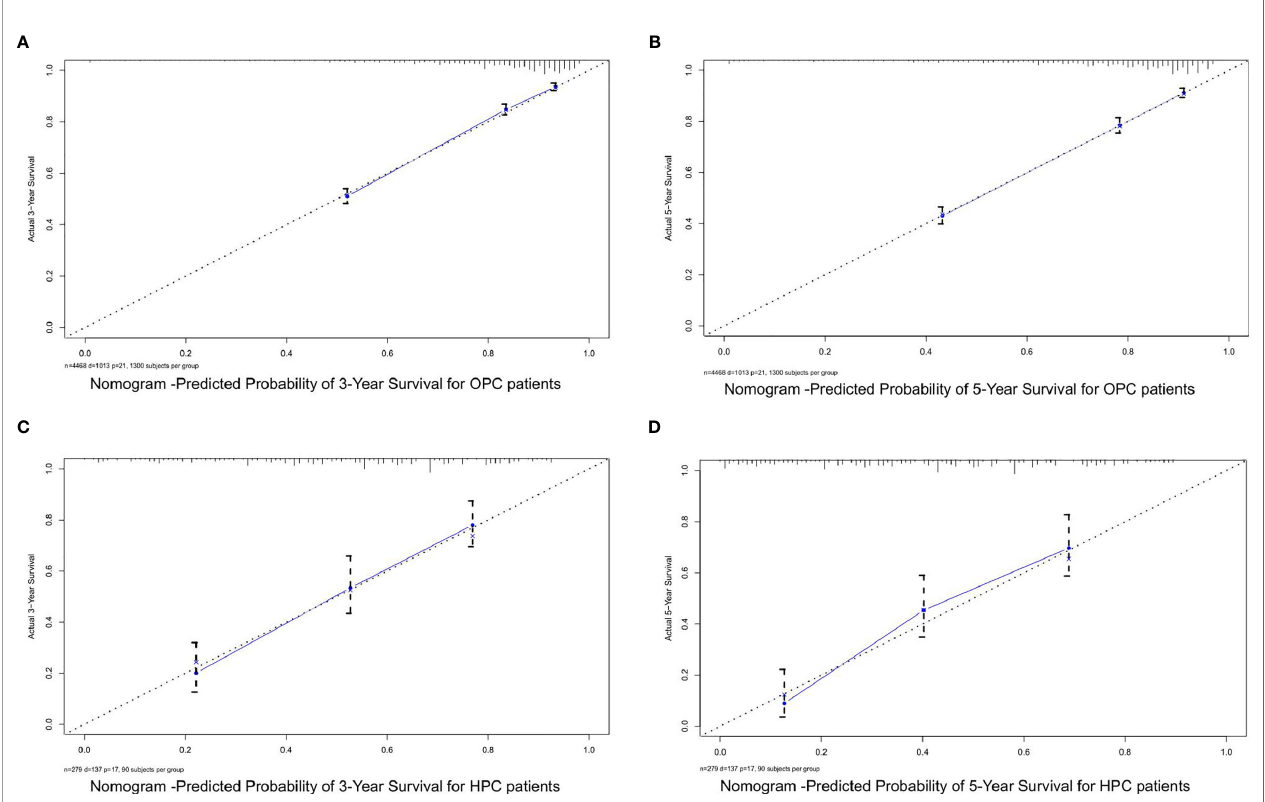
FIGURE 5 | The calibration curves for predicting the OS of OPC and HPC patients in the training cohorts. (A, B) Calibration curves for the 3- and 5-year OS of OPC patients in the training cohort; (C, D) calibration curves for the 3- and 5-year OS of HPC patients in the training cohort. OS, overall survival; OPC, oropharyngeal carcinoma; HPC, hypopharyngeal